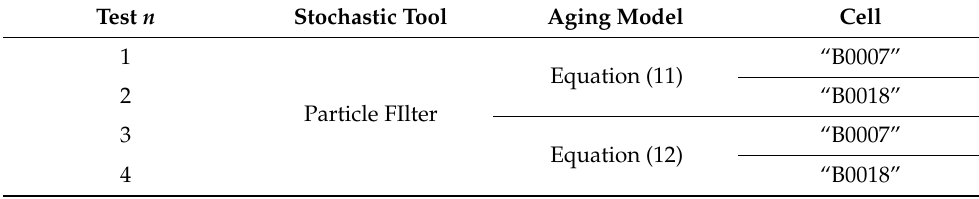
Table 6. Trials of the stochastic